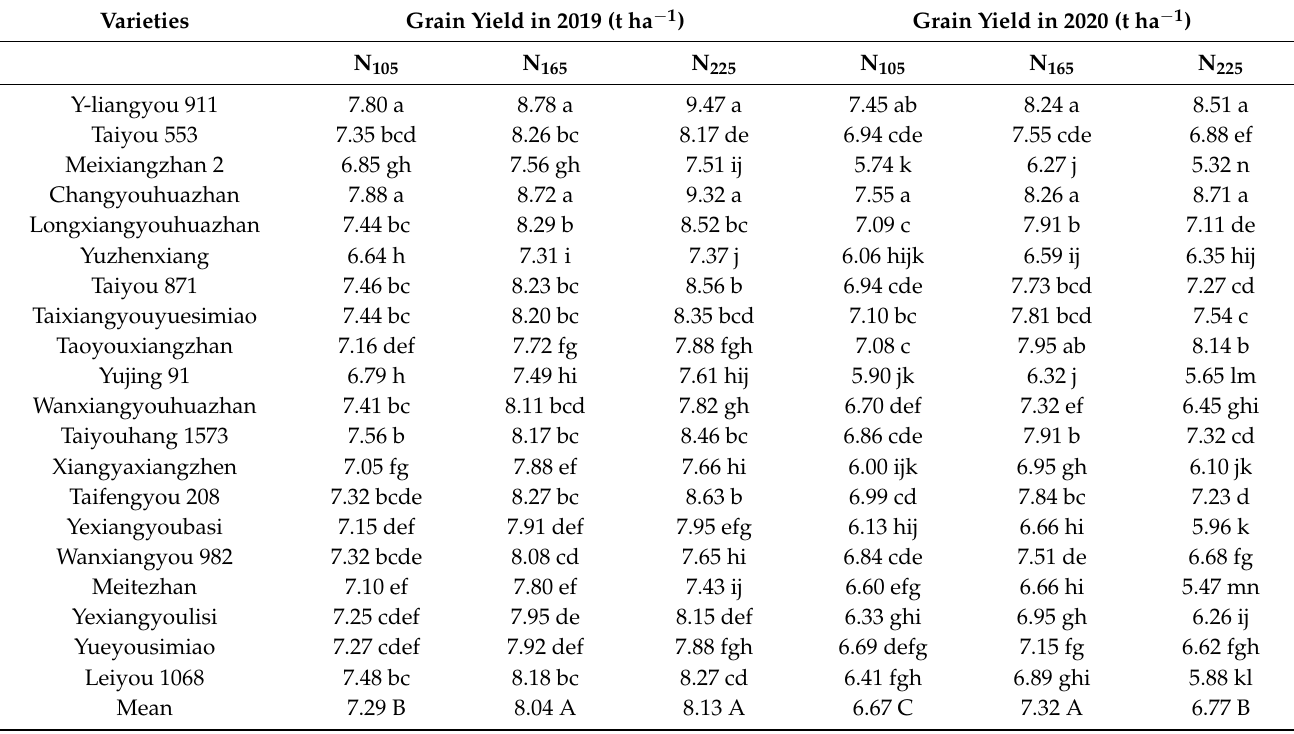
Table 3. Grain yield of high-quality rice varieties under different N application rates in 2019 and